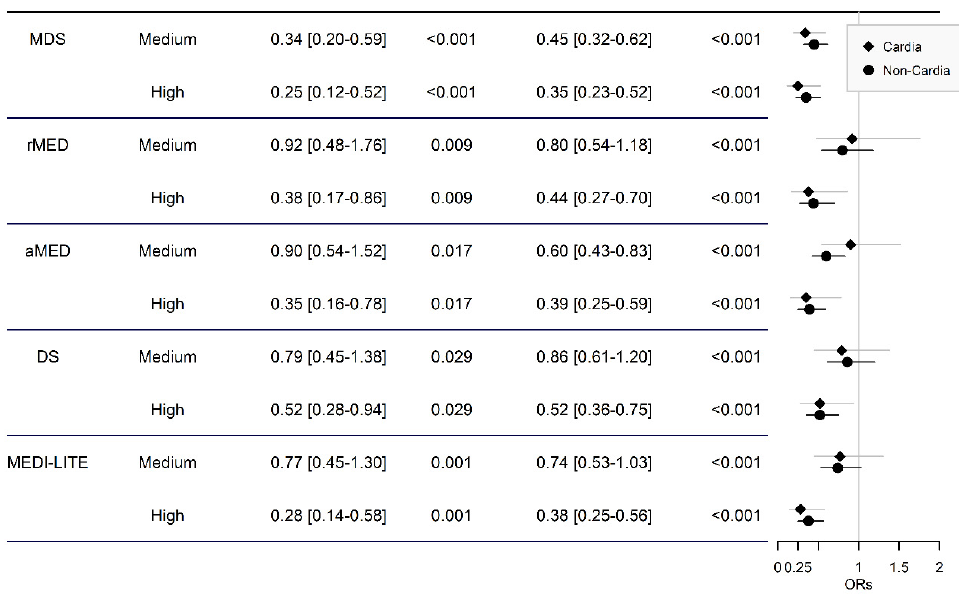
Figure 2. Odds ratios of risk of gastric cardia and non-cardia cancer according to adherence level to various indexes compared with low adhesion.